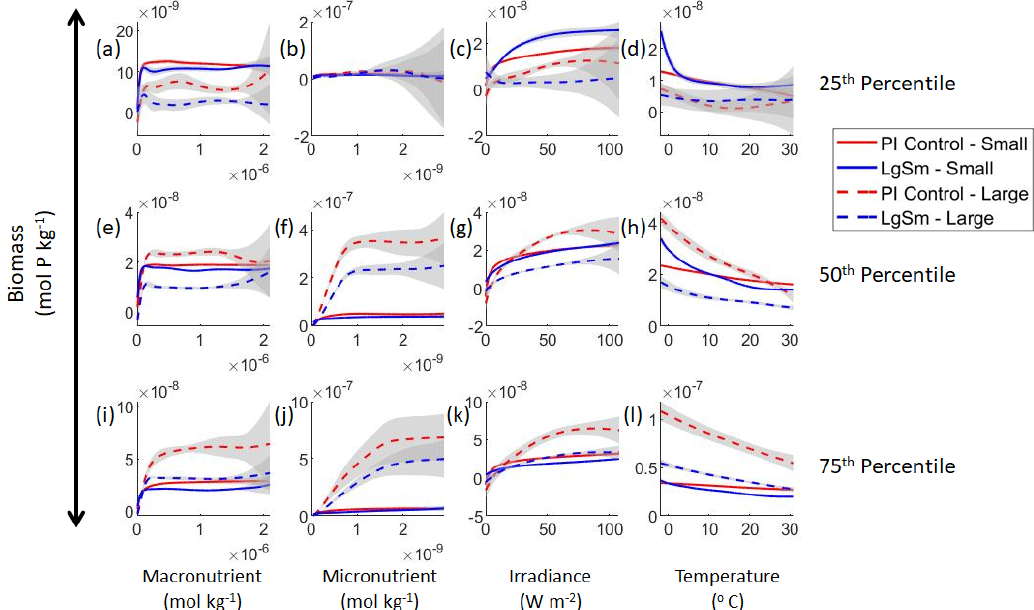
Figure 7. Sensitivity analysis plots for the small and large phytoplankton of Case 2. Each line is the prediction for the NNE (i.e., the average prediction of 25 NNs) specific to each model run, and the color of each line represents the model run (PI Control – red; LgSm – blue). The solid lines correspond to the small phytoplankton and the dashed lines to the large phytoplankton. The gray region around each line shows 1 standard deviation in the predictions of the individual NNs that make up each NNE (e.g., the gray region around the solid red curves shows the standard deviation in the predictions of the 25 NNs that make up that particular NNE). The rows correspond to the percentile value at which the other predictor variables were held constant (e.g., panel a varies the macronutrient across its min–max range and holds the micronutrient, irradiance, and temperature at their respective 25th percentile values). Columns show the x -axis variables as they vary between their min–max range. The y axis in all panels is the biomass concentration. Note that the biomass scale changes with each